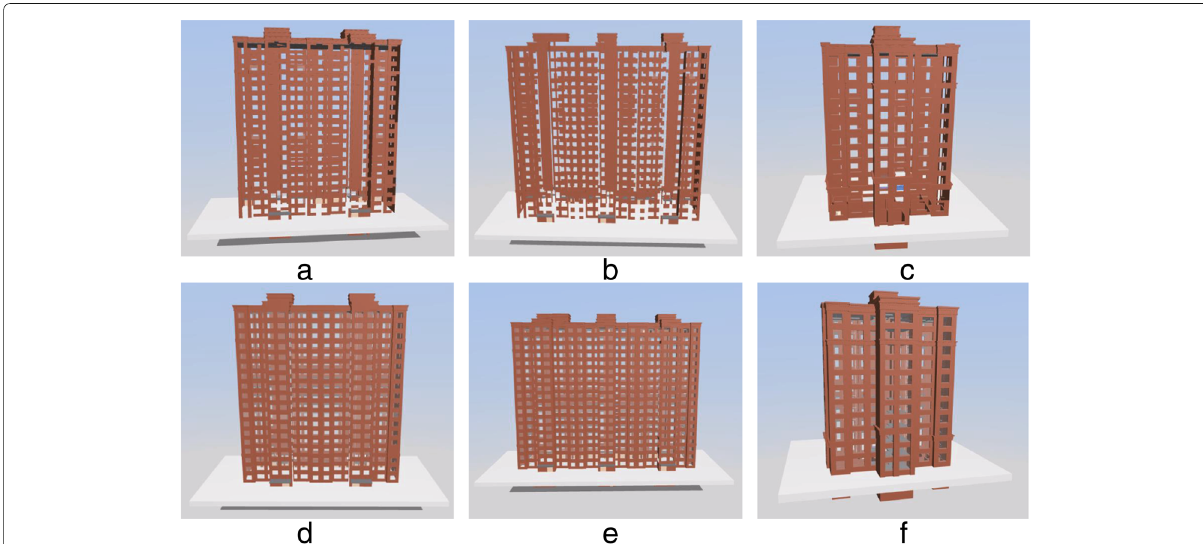
Fig. 10 Comparison of the results of the external component extraction between the bounding box based method and proposed method. a M1 b M2 c M3 d M1 e M2 f M3